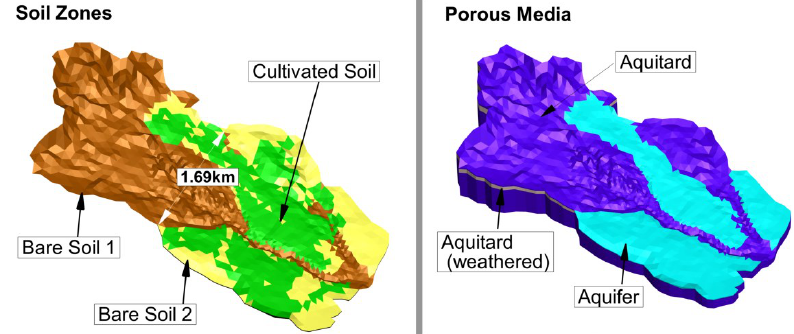
Figure 2. Soil and hydrogeological zones for the year 2009. Vertical exaggeration: 5 : 1. Modified from von Gunten et al. (2014,